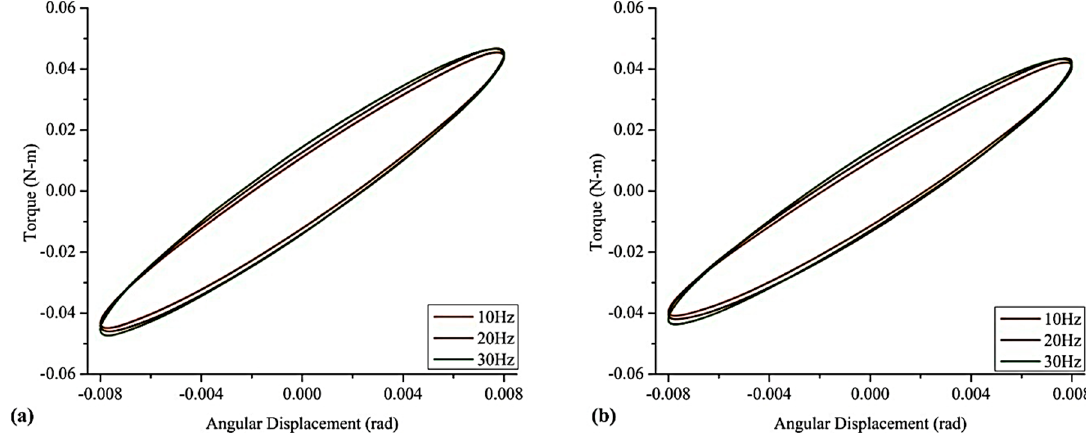
Figure 17. Complex torsional stiffness values at ( a ) 0 A (0 T) and ( b ) 5 A (0.28 T) under various frequencies [31] (reprinted with permission from Elsevier TM ).